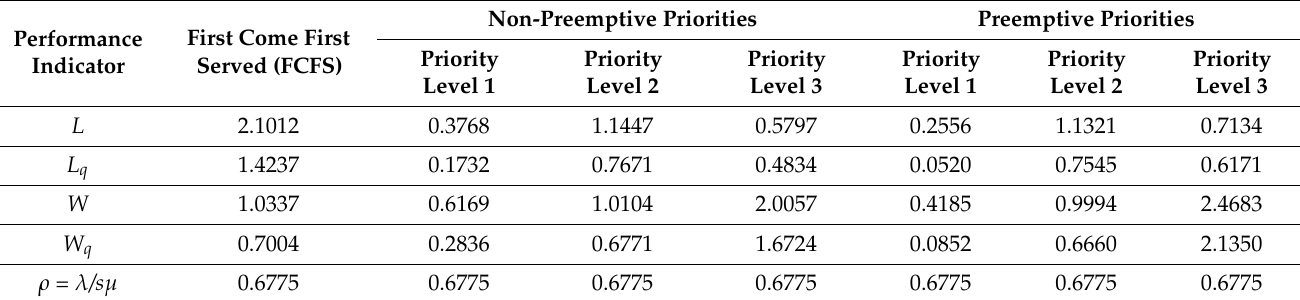
Table 6. Comparison of performance indicators of the queuing model with different priority levels.